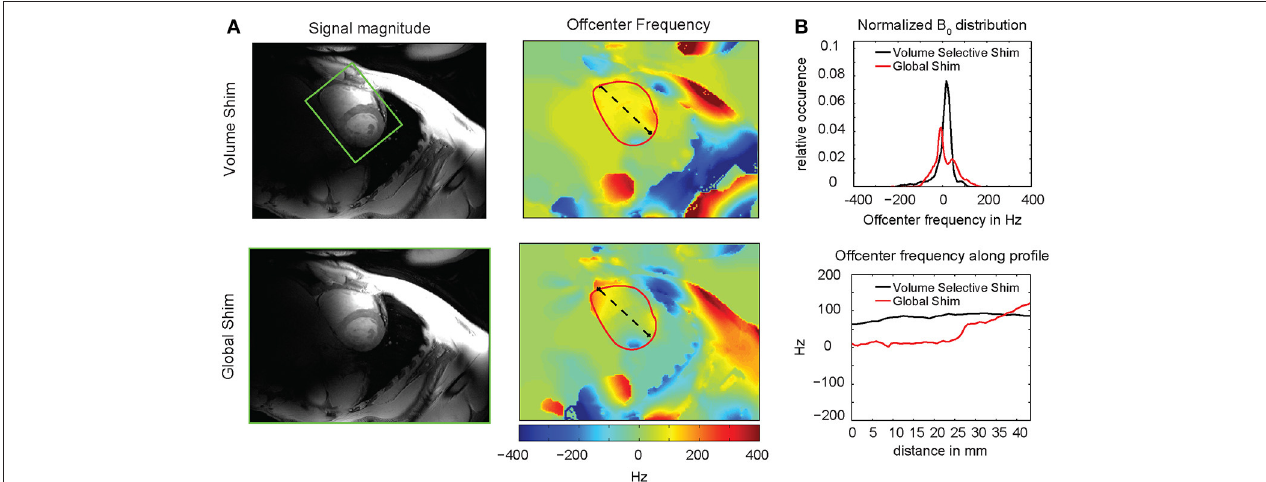
FIGURE 8 | Comparison between volume and global B 0 shimming in the heart of a healthy volunteer at 7.0 T. (A) left: placement of the adjustment volume in a magnitude image. (A) right: B 0 maps with the region of interest (red) and a profile across the heart through the ventricular septum (dashed black line) overlaid. (B) Plot of the histogram detailing the distribution of B 0 in the ROI outlined in the B 0 maps (top) and plots along the profile in the B 0 map (bottom) of volume selective (black) and global (red) shim. A clear improvement of field inhomogeneity can be observed after volume selective shimming indicated by a narrowing of the histogram and a flattened B 0 profile.